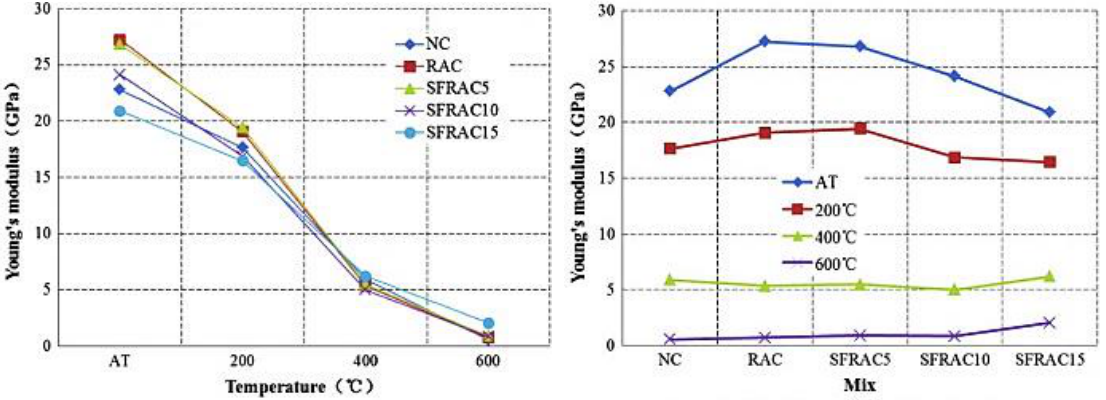
Figure 18. Young’s modulus of SF -reinforced recycled concrete at ambient and high temperatures. Copyright permission is obtained from [50].